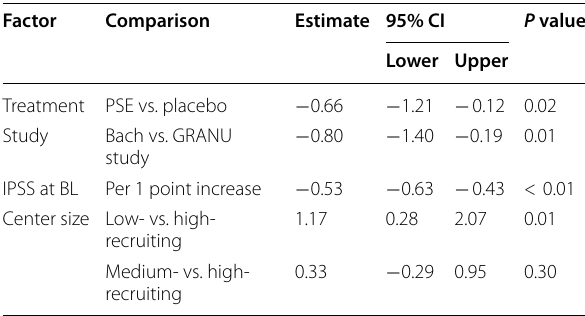
Table 6 Mean IPSS changes from baseline to 12 months estimated by ANCOVA (ITT set using LOCF)